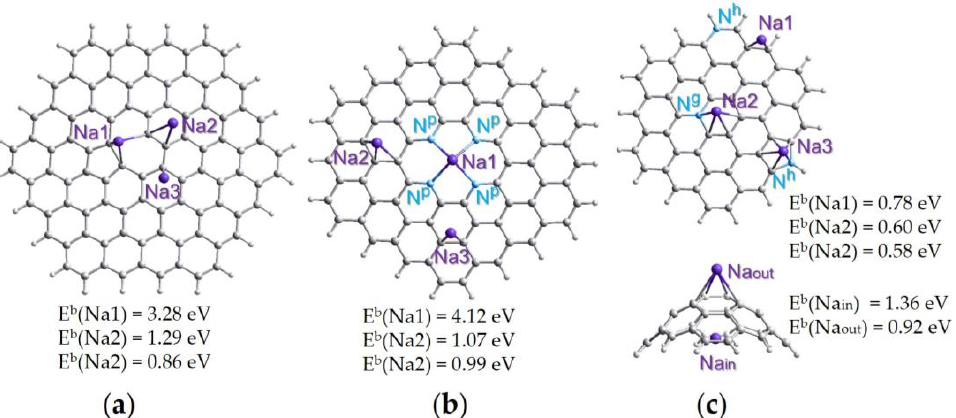
Figure 10. Graphene fragments with adsorbed Na atoms: ( a ) graphene with monovacancy, ( b ) graphene with double vacancy terminated with four pyridinic nitrogen (N p ) atoms, and ( c ) graphene with graphitic (N g ) and edge-hydrogenated nitrogen (N h ) located in pentagon and hexagon (top model) and curved graphene fragment with two pentagons (bottom model). The edges of fragments end with hydrogen atoms. Bonds between Na and the support are shown for distances less than 0.27 nm. The binding energy E b is calculated for each new Na atom.